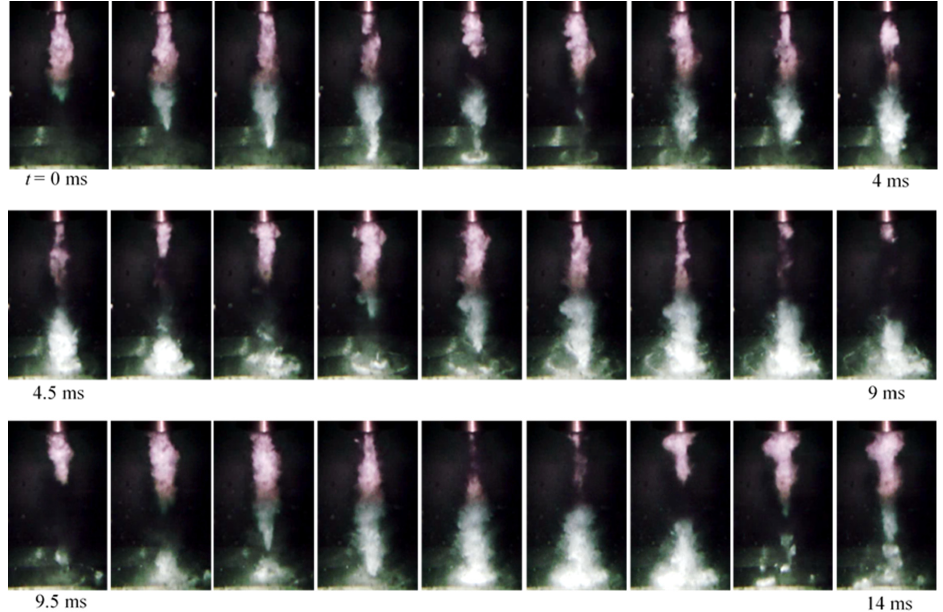
Figure 7. Aspect of impinging cavitating jet observed by high-speed video camera.